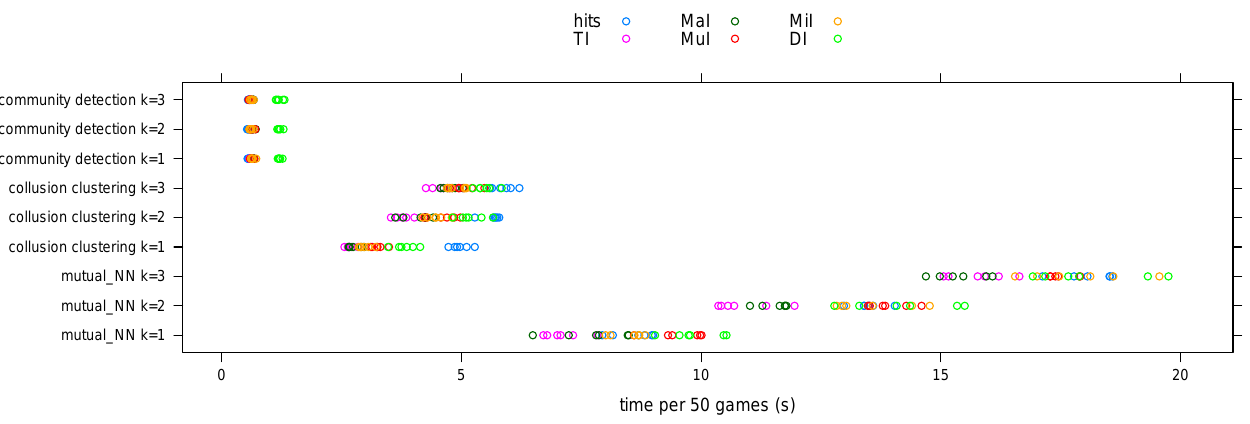
Fig. 3. Time required to get the clustering result from a batch of 50 games. For community detection the k parameter is only used for the pruning step and as minimal effect on execution